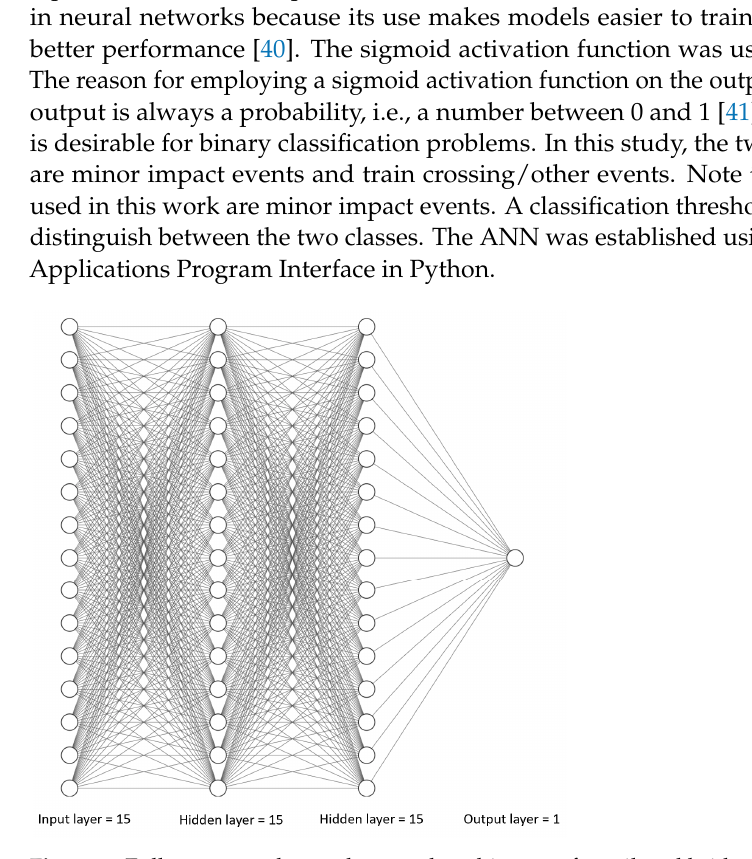
Figure 7. Fully connected neural network architecture for railroad bridge event classi fi cation.